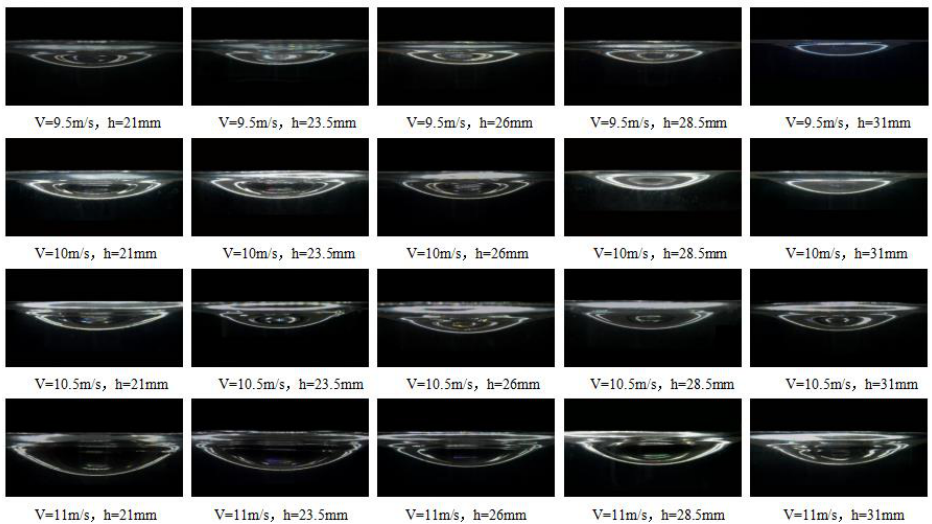
Figure 12. Experimental results of the gas jet forming.